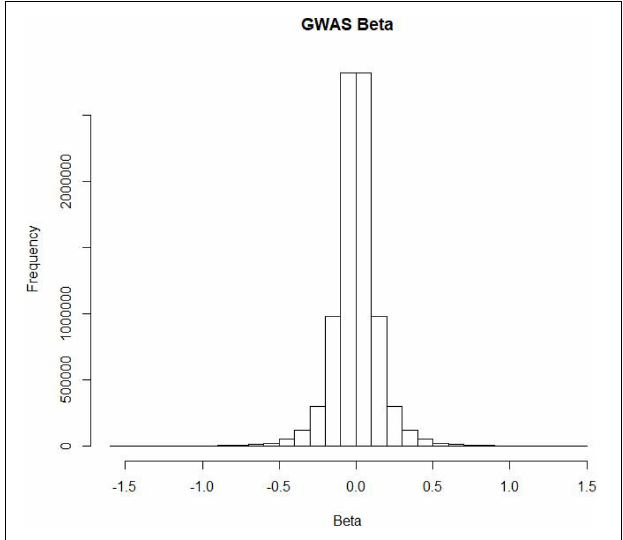
FIGURE 1 | The distribution of GWAS beta in severe COVID-19 patients.